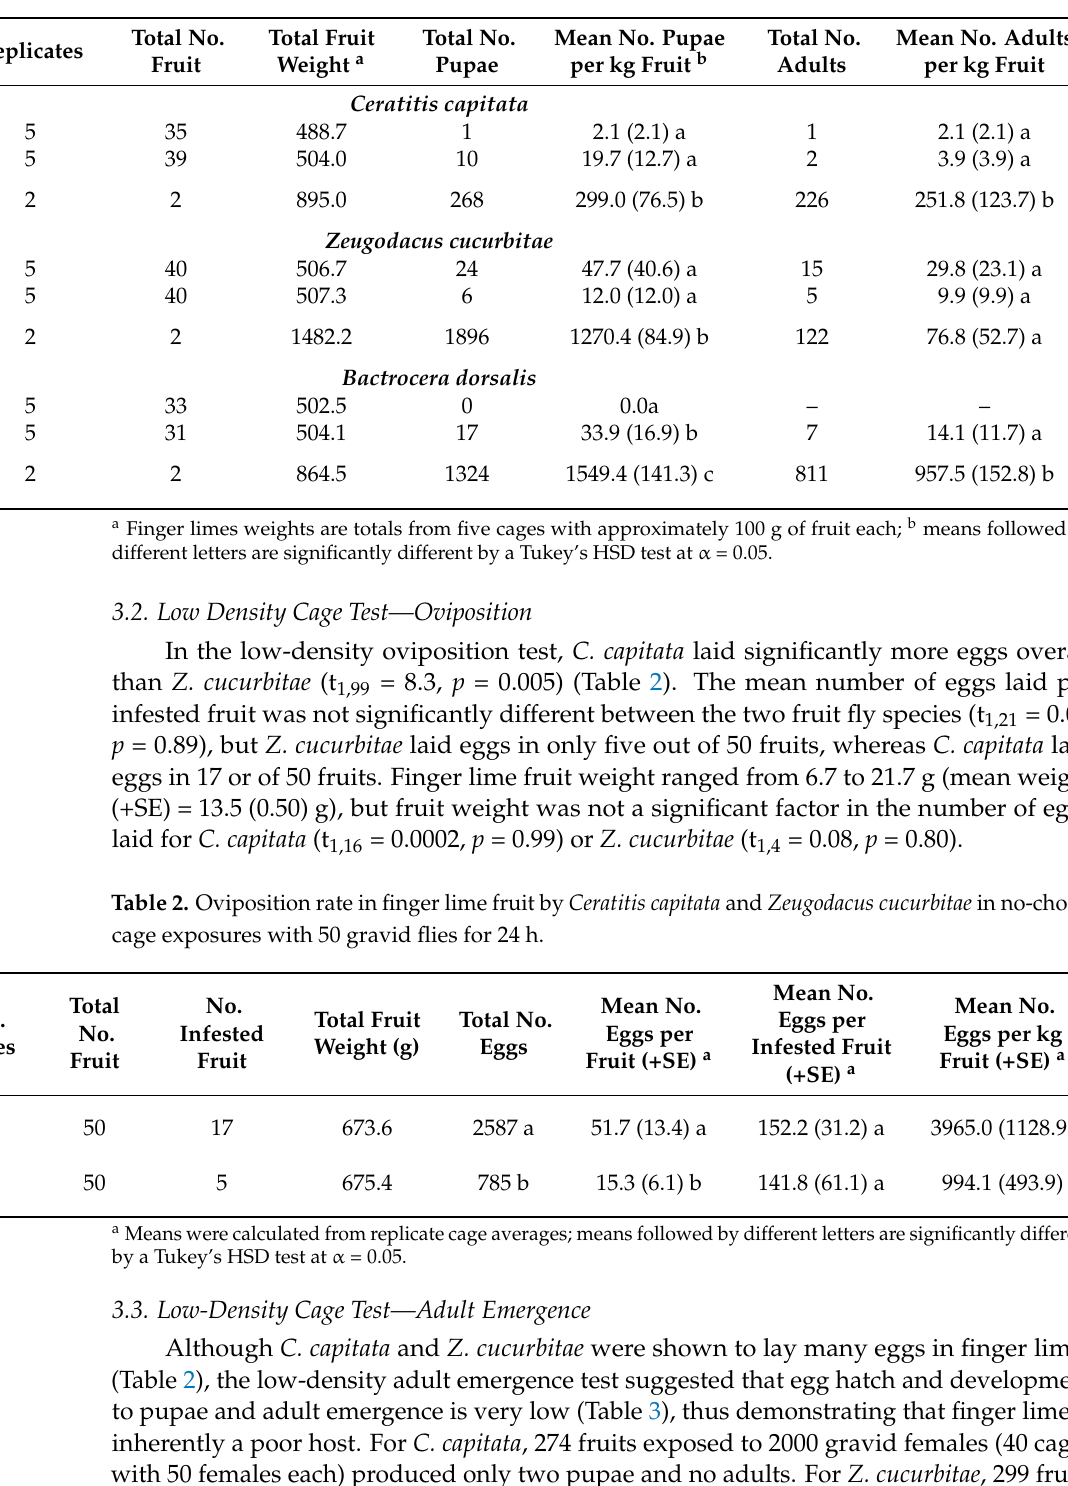
Table 1. Host suitability of finger lime fruit to three tephritid fruit flies using no-choice laboratory cage exposures with 500 flies (~1:1, male:female) for 24 h.